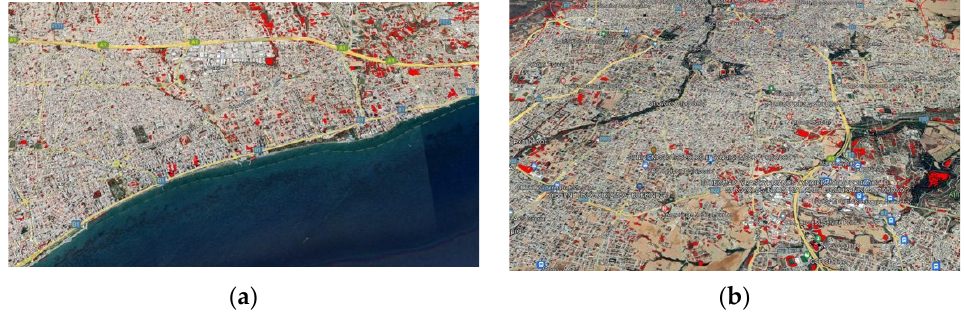
Figure 12. Changes tracked in optical images visualized on Google Earth: ( a ) Limassol; ( b ) Nicosia.